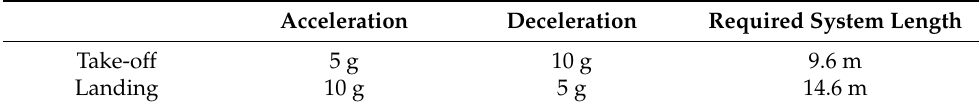
Table 13. System length with use of LMDs, including a 0.2 s synchronisation